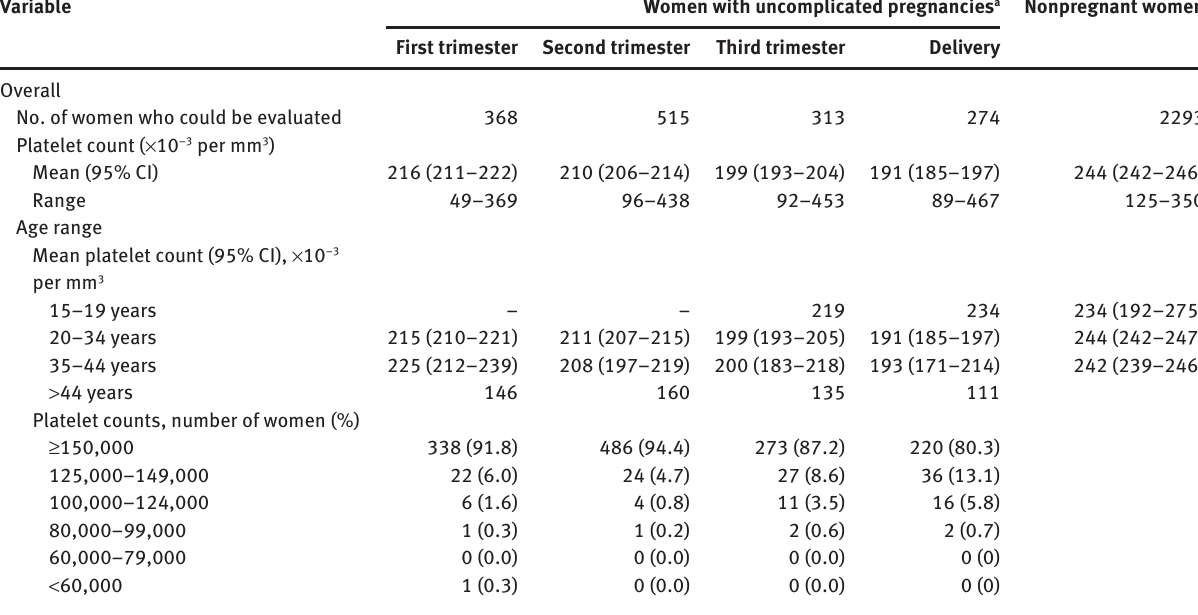
Table 1: Platelet counts during pregnancy and in nonpregnant